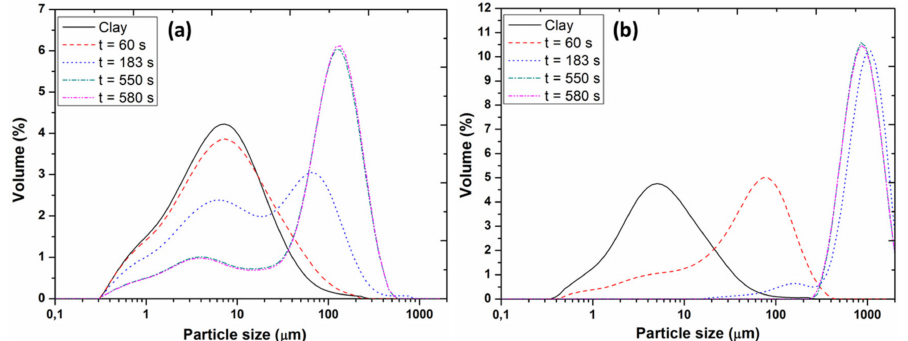
Figure 5. Particle size distribution for 0.7 g / L clay concentration with ( a ) 0.5 mg / g and ( b ) 2.5 mg / g cationic flocculant. “Clay” represents the PSD of pure clay before addition of flocculant and t = 0 s corresponds to the time when the flocculant was added.